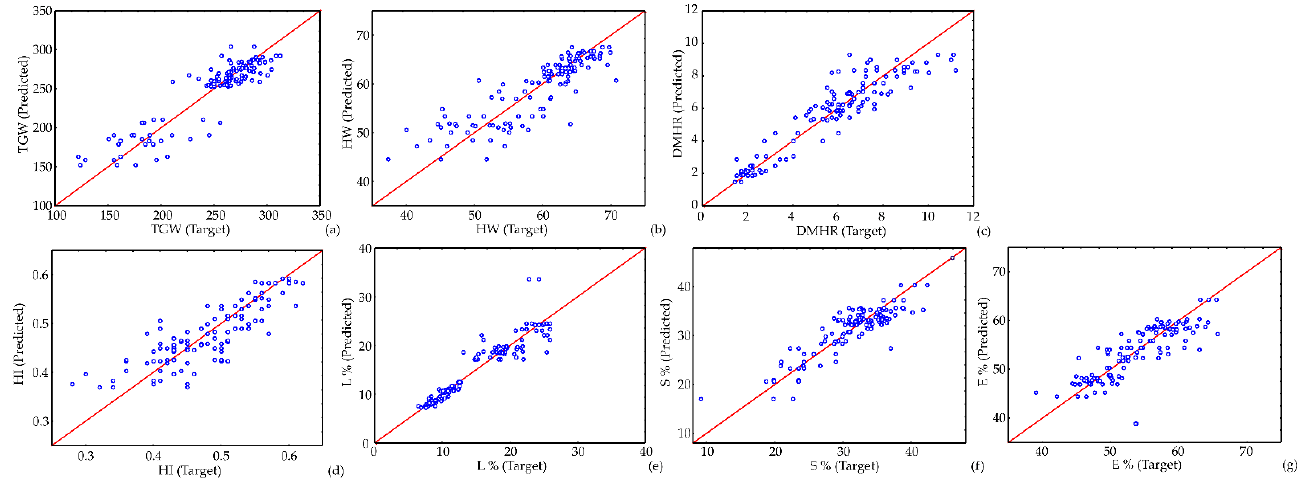
Figure 5. Comparison of experimentally obtained values of ( a ) TGW, ( b ) HW, ( c ) DMHR, ( d ) HI, ( e ) L, ( f ) S, and ( g ) E, with ANN predicted values.